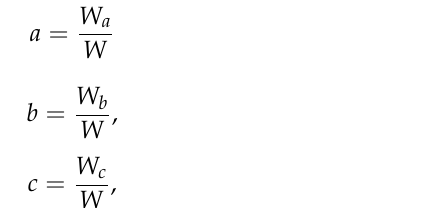
Table 2. Minimum depths of installing underground networks. Type of Underground Network